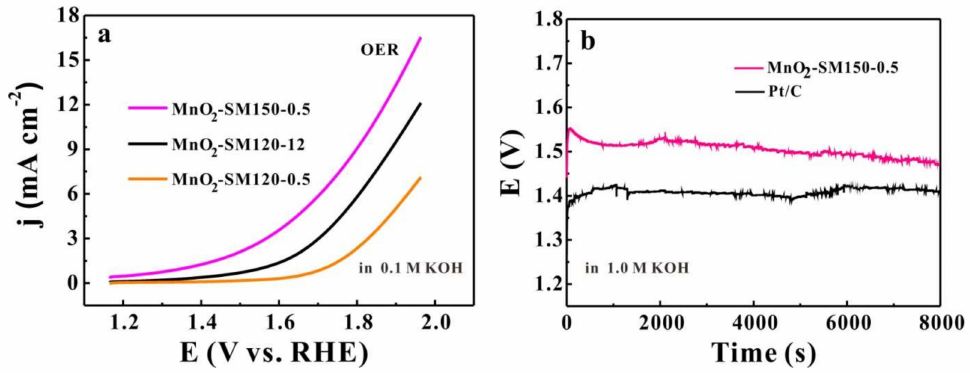
Figure 6. The oxygen evolution reaction (OER) performances of MnO 2 -150-0.5 and MnO 2 -120/12 are evaluated by LSVs in 0.1 M of KOH solution at a scan rate of 10 mV s − 1 with a rotation speed of 1600 rpm ( a ); the stability test of OER activity of MnO 2 -SM150-0.5 and Pt/C samples in 1.0 M of KOH solution at a current density of 10 mA cm − 2 for 8000 s ( b